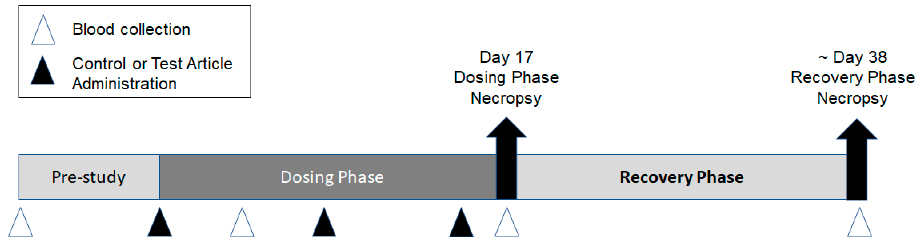
Figure 1. Overview of experimental design. Male and female Wistar Han rats (15/sex/group) were administered 3 once weekly intramuscular injections ( ) of control (saline or vehicle), BNT162b1 administered 3 once weekly intramuscular injections (30 or 100 µg), BNT162b2 V8 (100 µg), BNT162b2 V9 (30 µg), or BNT162b3 (30 µg). Animals were